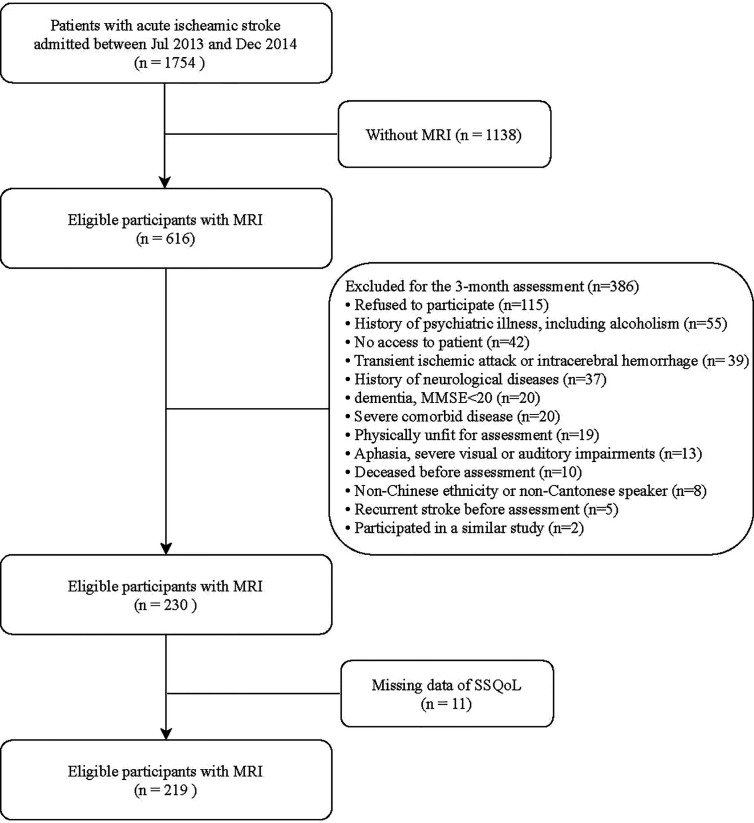
Flow chart of the enrollment.